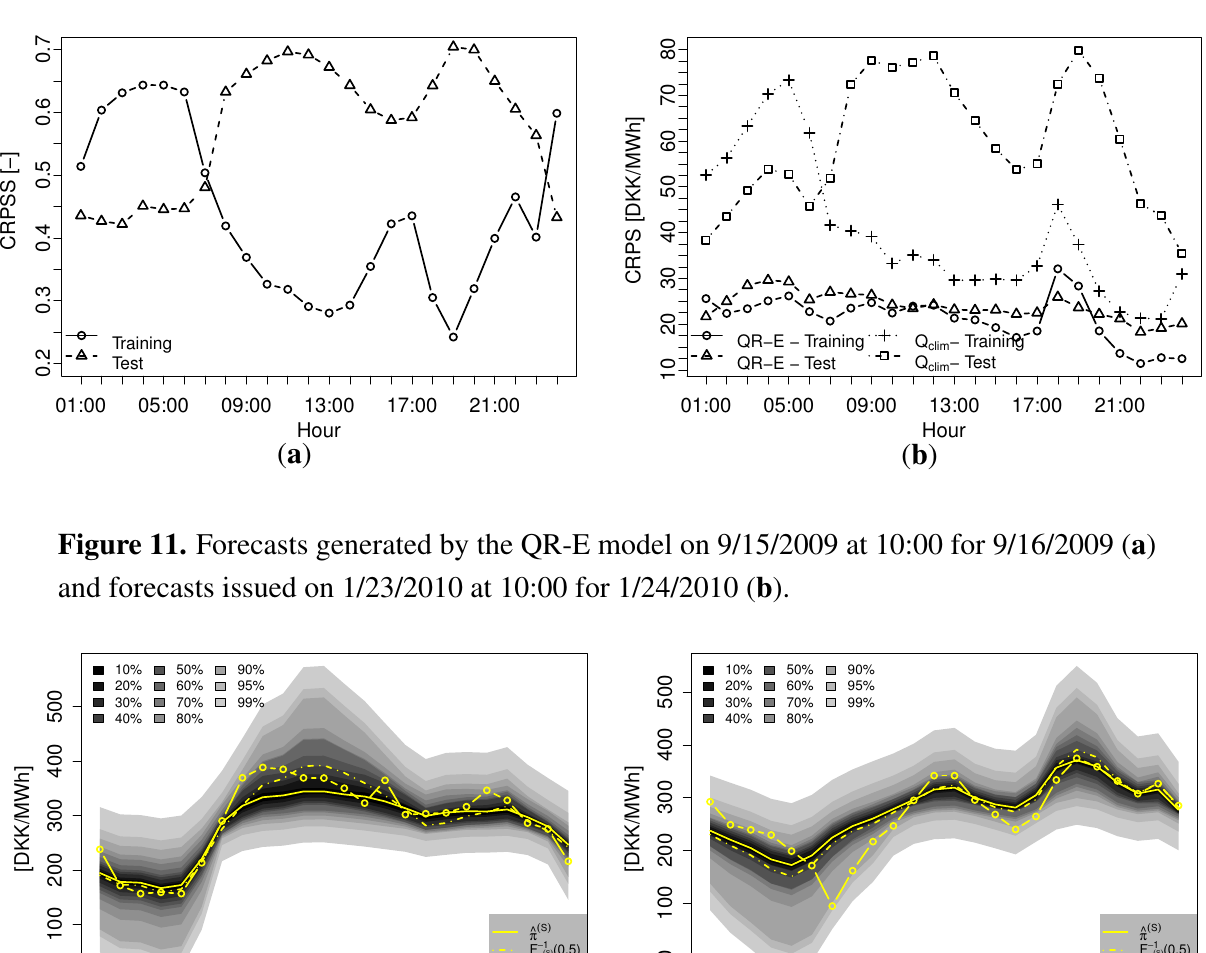
Figure 10. Hourly CRPSS for the QR-E model ( a ) and the hourly CRPS values for the QR-E model and the climatology one ( b ).